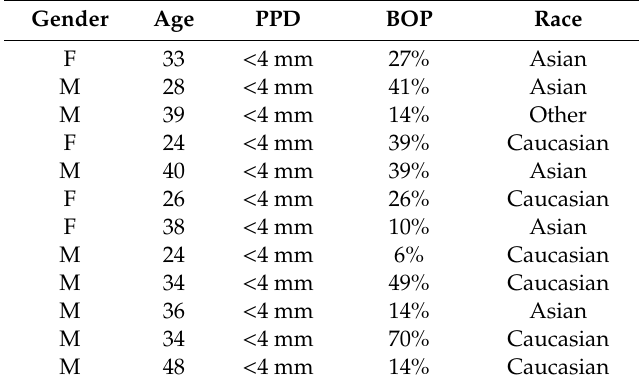
Table 1. Participant data.